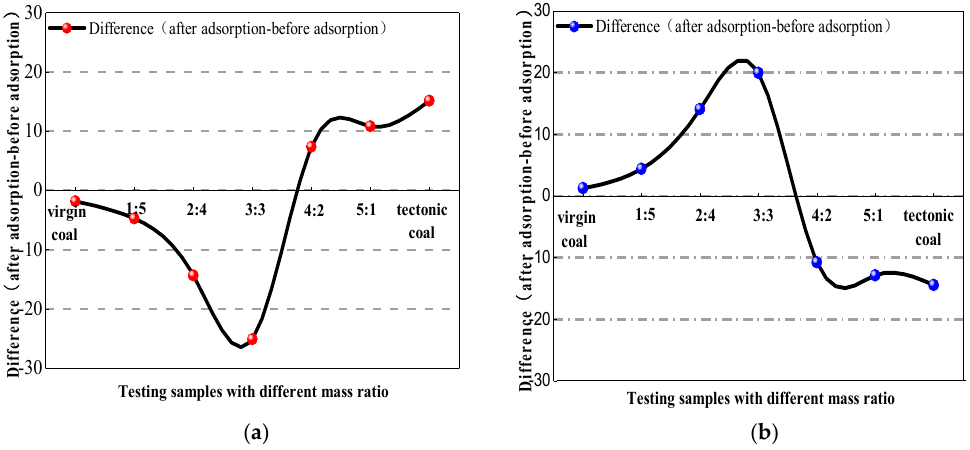
Figure 9. Variation in the difference of mass ratios of coal samples before and after adsorption. ( a ) Difference of macro pores’ specific surface area; ( b ) Difference of micro pores’ specific surface area.